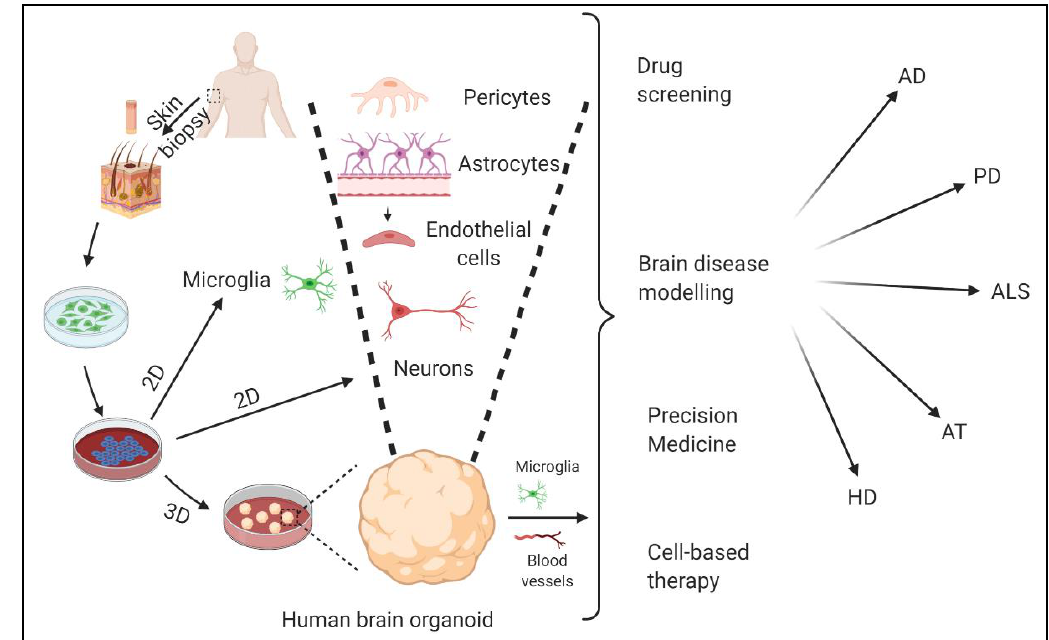
Figure 4. Potential of 2D iPSCs and 3D-organoids to models NDDs. Skin fibroblasts derived from NDD patients can be reprogrammed into iPSCs. These iPSCs can be differentiated into various brain cell types including different neuron types, microglia, etc. iPSC-derived 3D-organoids contain most of the brain cell types (except microglia and vasculature, which can be co-cultured with 3D-organoids) and are able to show major disease phenotypes. Various applications of these model systems have also been shown. Created with BioRender.com.